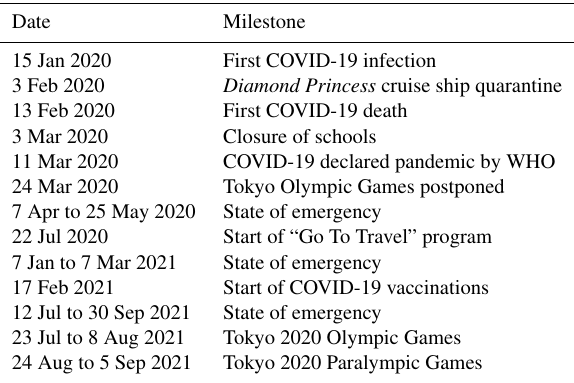
Table 1. Milestones of the COVID-19 pandemic in